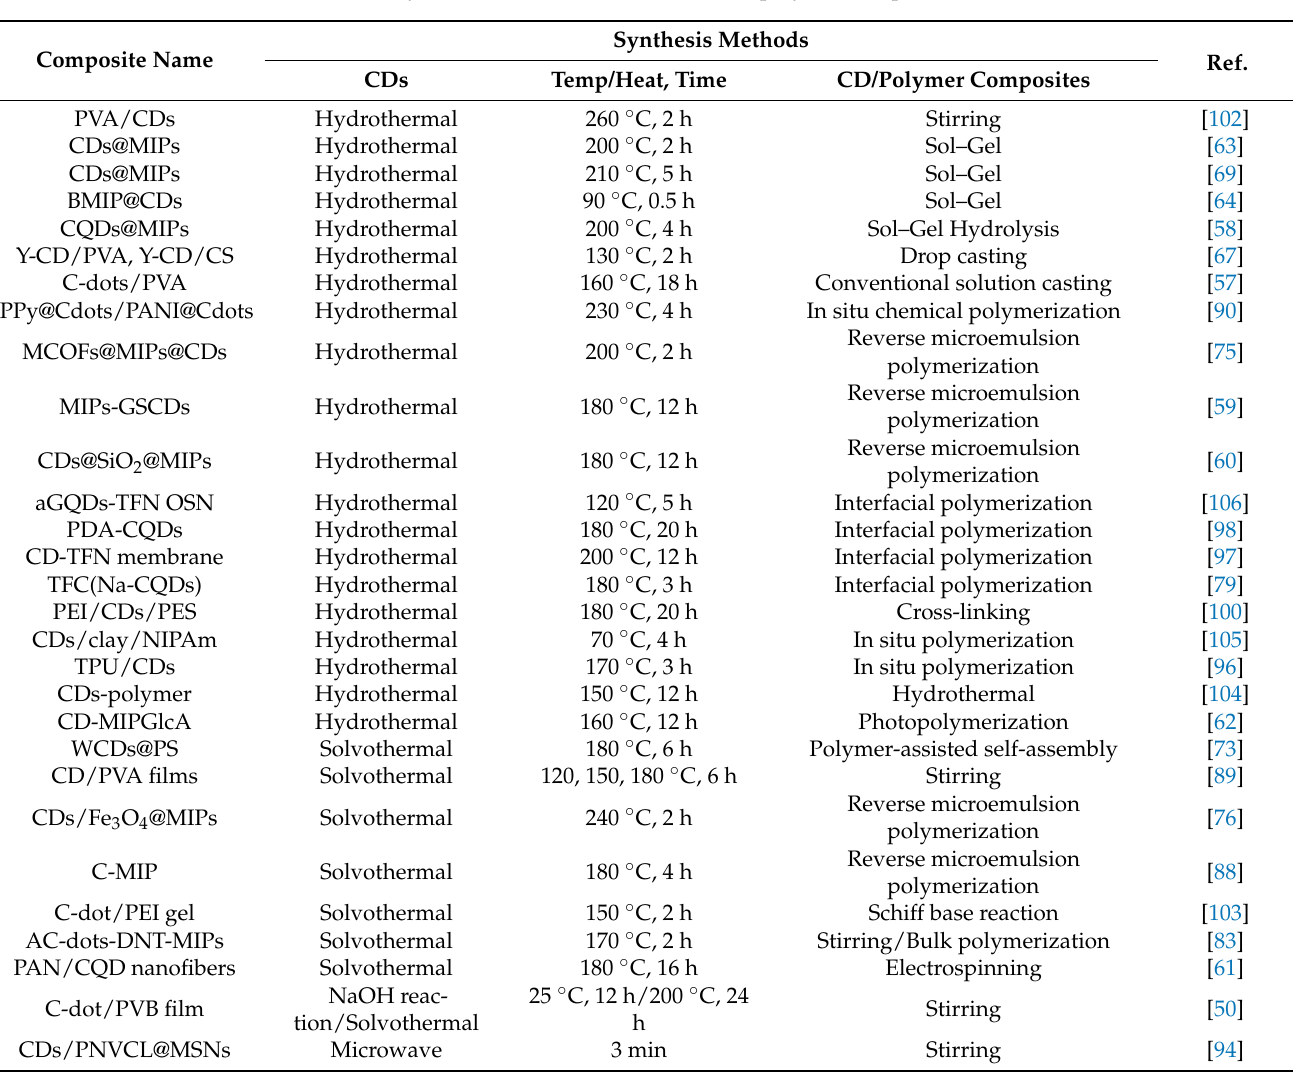
Table 2. Synthesis methods for CDs and CD/polymer